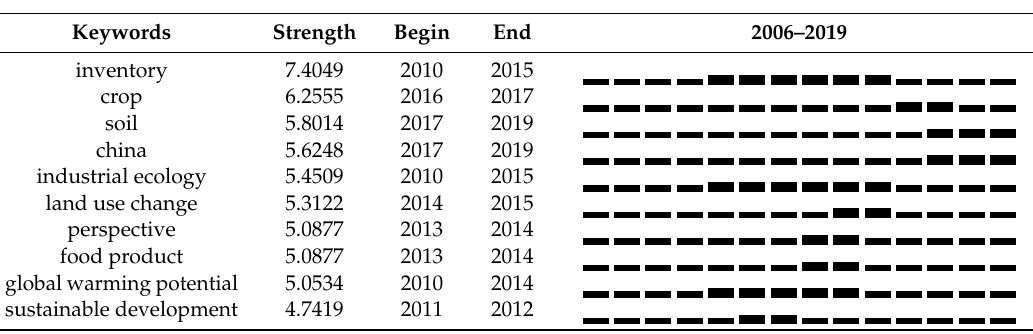
Table 11. Top 10 keywords based on citation burst